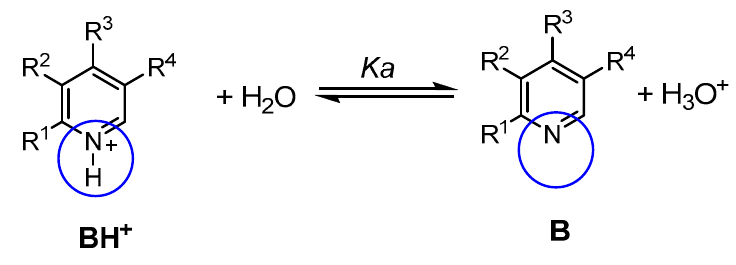
Figure 1. p Ka values of the nicotinamide, isoniazid, and pyridoxine hydrochloride were determined.